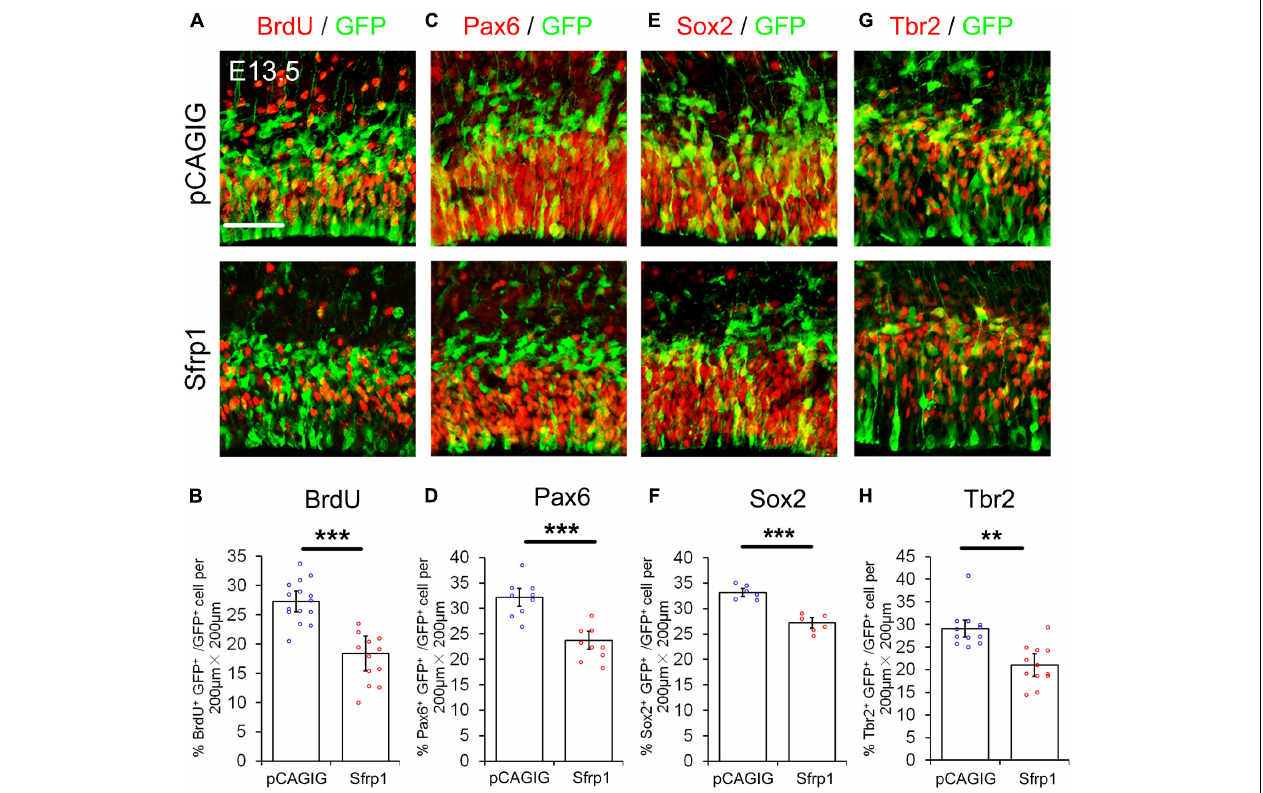
FIGURE 4 | Sfrp1 negatively regulates proliferation of NPs at E13.5. (A,C,E,G) Overexpression of Sfrp1 in E12.5 cortices using in utero electroporation, analyzed at E13.5, caused the reduction of BrdU + /GFP + , Pax6 + /GFP + , Sox2 + /GFP + , and Tbr2 + /GFP + neural progenitors. (B,D,F,H) The proportion of cells labeled with individual progenitor markers and GFP versus cells labeled with GFP was quantified. Values represent mean ± SEM, and each dot represents a data point of the marker + GFP + /GFP + % in each section (200 µ m × 200 µ m). n = 3, at least two sections from each brain. ∗∗ P < 0.01; ∗∗∗ P < 0.001; unpaired Student’s t -test. Scale bar: 50 µ